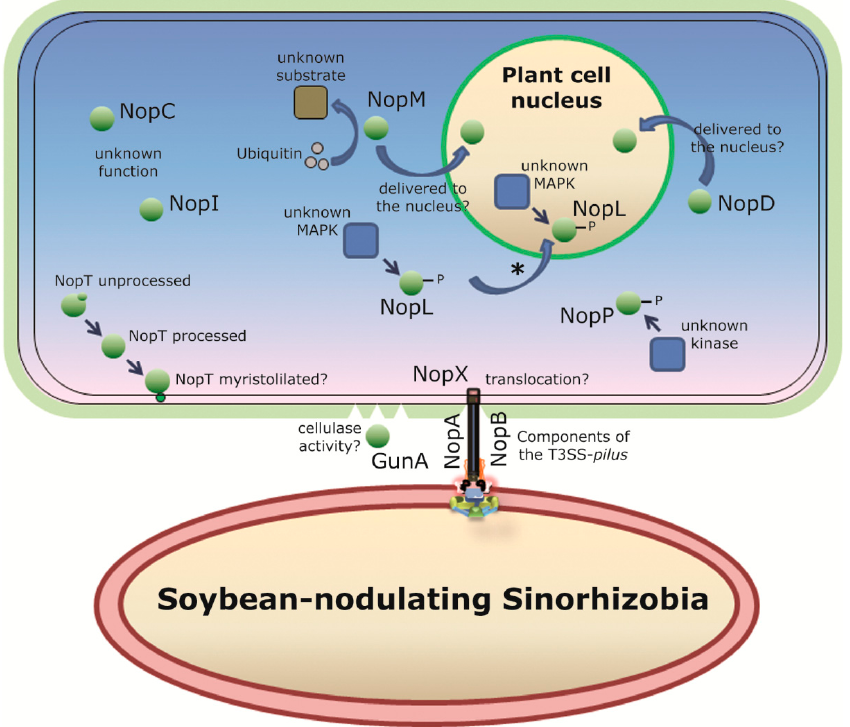
Figure 4. Functions and localization in the plant cell of different sinorhizobial nodulation outer proteins. Potential functions are discussed in the main text. Proteins secreted by the T3SS (Nop) are in